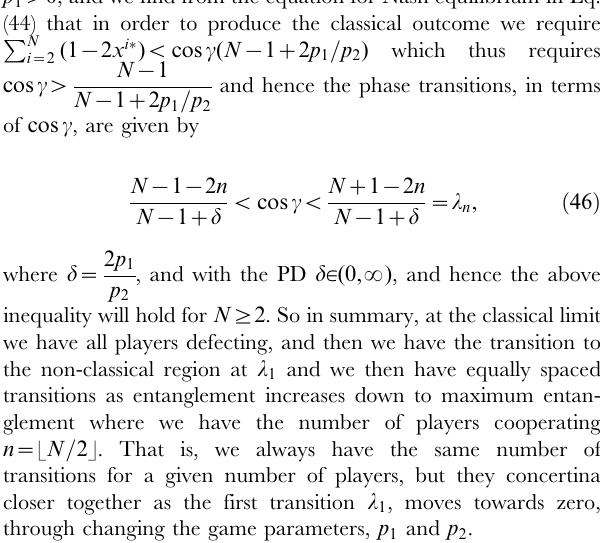
Figure 2. Phase structure for N -player Prisoner dilemma. For cos c w l 1 we identify the classical regime, where all players defect, and as entanglement increases we find an increasing number of players cooperating, up to t N = 2 s near maximum entanglement. The left and right hand edges of the boundaries each form an inverted parabola in cos c given by Eq. (51).